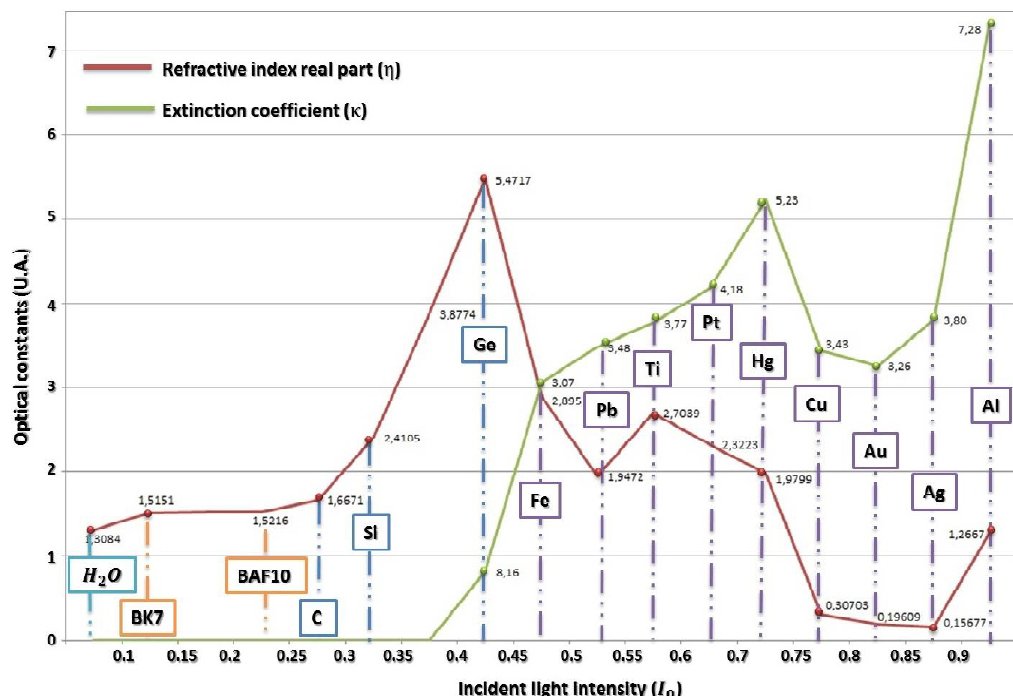
Fig. 6. Graph showing refractive index real part and extinction coefficient as optical constants versus incident light intensity.